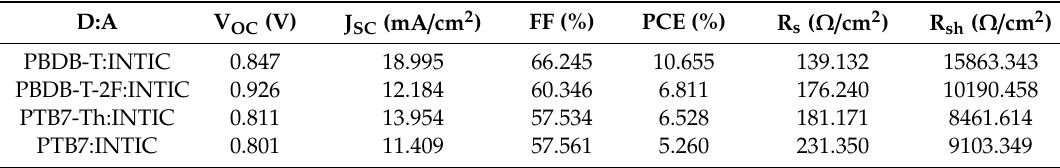
Figure 6. ( a ) J-V characteristics of the PSCs with different donors under irradiation of 100 mW/cm 2 with reverse scan; ( b ) J ph -V eff characteristics of the devices with different donors. Table 1. Summary of OPVs devices’ performance of PTB7:INTIC, PTB7-Th:INTIC, PBDB-T:INTIC and PBDB-T-2F:INTIC fabricated from CF with CN as an